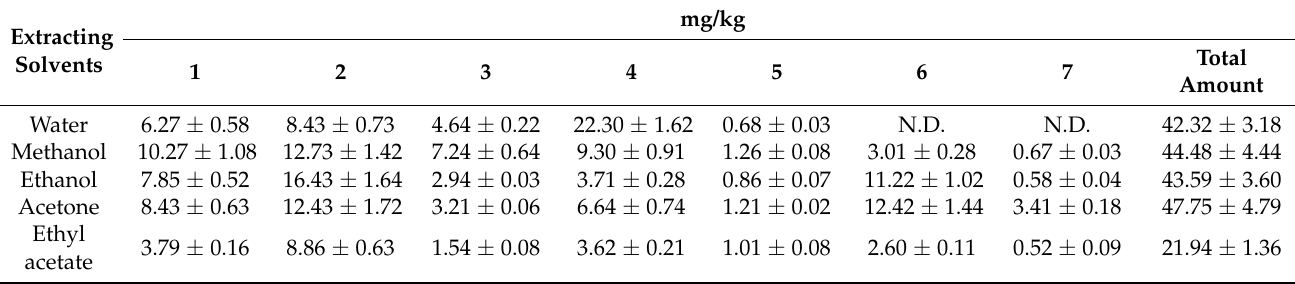
Table 4. Quantification and identification of the main active compounds from Ampelopsis japonica in various